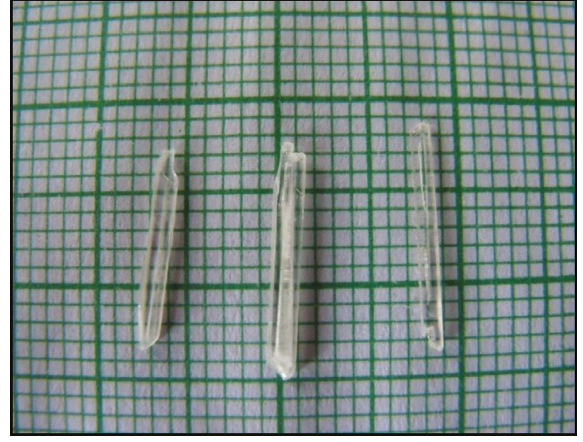
Figure 2: As-grown crystal of BDSC.